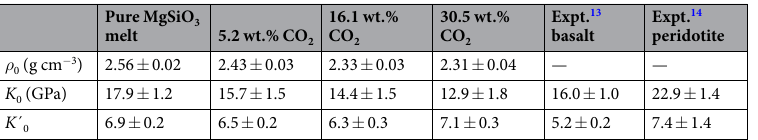
Table 1. Equation of state parameters. The 3 rd order Birch Murnaghan equation of state P ( ρ , T 0 ) used to represent the reference isotherm of T 0 = 3000 K. The experimentally adopted parameters for carbonated basaltic melt (containing 5 wt.% CO 2 ) 13 using the data at 16–20 GPa and 2573 K and those for carbonated peridotitic melt (containing 2.5 wt.% CO 2 ) 14 using data up to 3.8 GPa at 2100 K. Note: The calculated values of linear coefficient ( B TH ) in the thermal pressure term as a function of compression for pure and 5.2. 16.1, and 30.5 wt.% CO 2 -bearing silicate liquids can be accurately described by the same